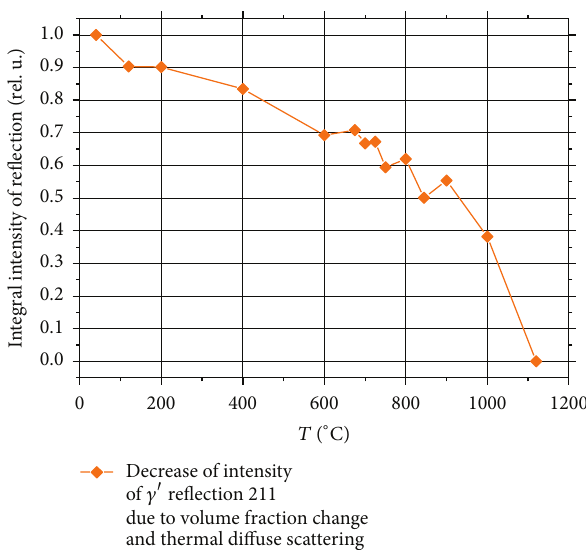
Figure 4: The integral intensity of the 𝛾 󸀠 reflection 211 (after background subtraction) in dependence on